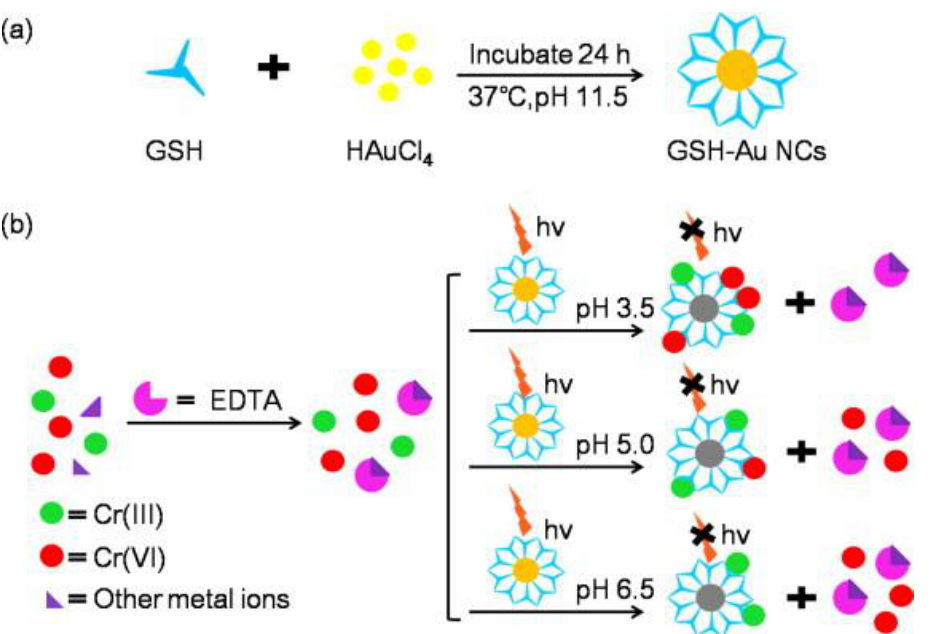
Figure 11. Schematic diagram of synthesis of GSH-Au NCs ( a ) and realization of detection of Cr(III) and Cr(VI) ( b ). Reprinted with permission from Ref. [33]. Copyright © 2013 Elsevier B.V.